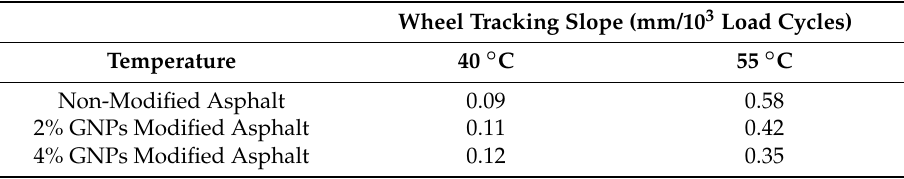
Table 6. The Wheel Tracking slope. GNPs = Graphene Nano-Platelets.